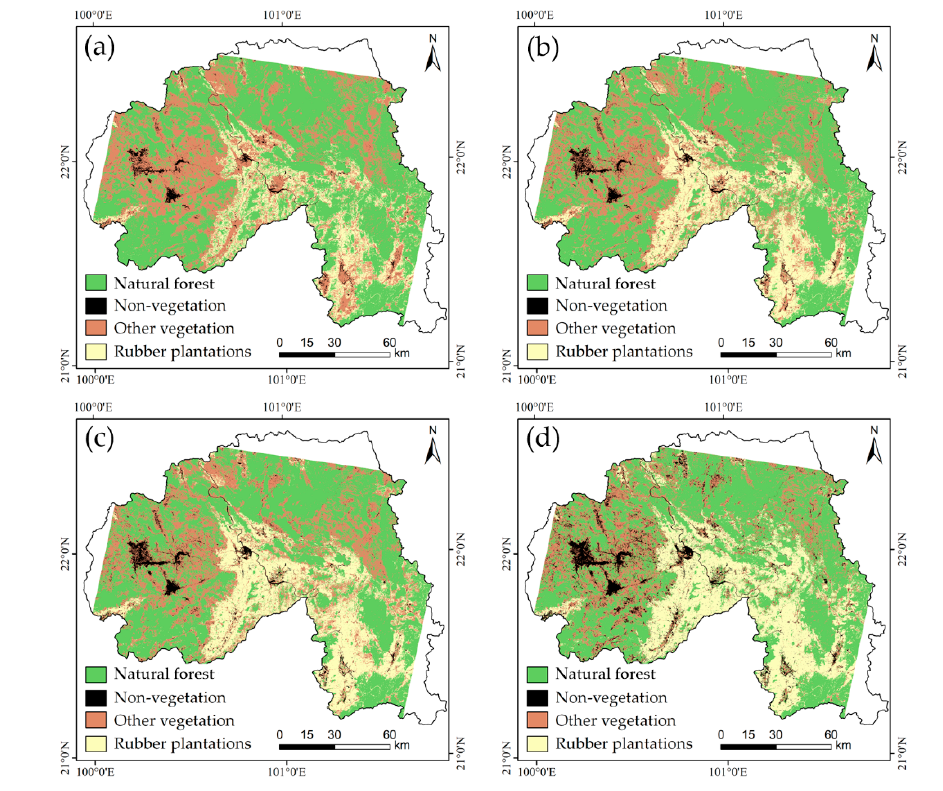
Figure 10. Classification results for: ( a ) 2000; ( b ) 2005; ( c ) 2010; ( d ) 2015. Table 11. Classification accuracies in 2000, 2005, 2010, and Table 10. Classification accuracies comparison of different classification schemes.